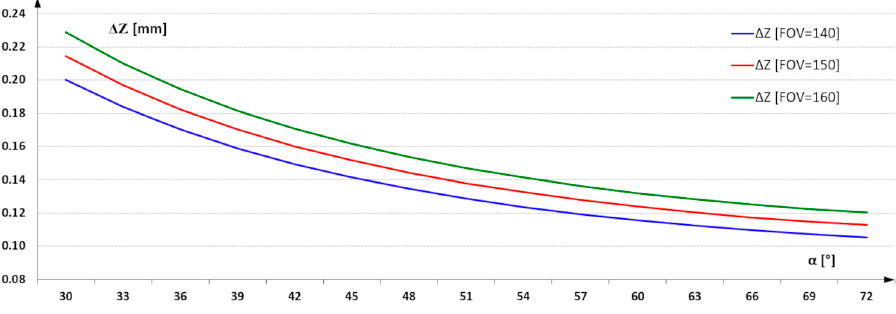
Figure 4. 3D imaging resolution in Z ‐ axes as a function of α